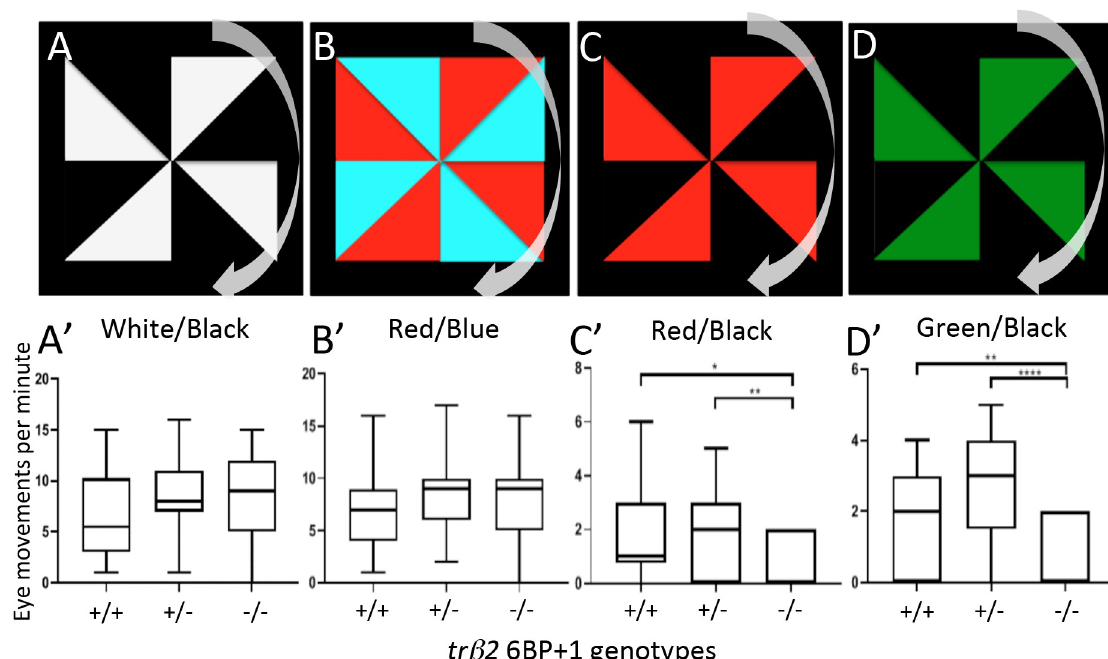
Fig 13. Optokinetic response tests. (A, B, C, D) Each larva at 9 dpf was exposed to these four stimuli in left to right order. The pinwheel patterns moved clockwise. (A’, B’) The wild type, 6BP+1 heterozygote, and 6BP+1 mutant responded similarly to the white/black and red/ blue stimuli. (C’, D’) The mutant had significantly less eye movements in response to the red/black and green/black stimuli. There was one repetition for each wild type (N = 30), heterozygote (N = 37), and mutant (N = 19) larvae. Monitor peak wavelengths are red (~610 nm), green (~550 nm), and blue (~450 nm). Significance is calculated with Mann-Whitney U test. red/black, and green/black pinwheels (Fig 13A, 13A’, 13B, 13B’, 13C, 13C’, 13D and 13D’). The 6BP+1 homozygous mutant fish (-/-) show OKR responses for white/black and red/blue pinwheels, but not red/black (~610 nm) or green/black (~550 nm) pinwheels. The mutant red/ black OKR responses (Mdn = 0.0) were significantly lower than WT (Mdn = 1.0) ( Mann Whit- ney , U = 188, P < 0.05) and the heterozygous mutant (Mdn = 2.0) ( Mann Whitney , U = 197, P < 0.01, Fig 13C’). There was a significant decrease in the number of green/black OKRs between the homozygous mutant fish (Mdn = 0.0) and WT (Mdn = 2.0) ( Mann Whitney , U = 168, P < 0.01) or heterozygous mutant (Mdn = 3.0) ( Mann Whitney , U = 118, P < 0.0001. Fig 13D’). In respect to OKR behavior, the 6BP+1 tr β 2 mutant fish do not respond to the mon- itor colors red (~610 nm) or green (~550 nm). Both colors selectively stimulate zebrafish red cones. This suggests the 6BP+1 mutants, lacking red cones, can use shorter-wavelength cones for OKR given the positive responses to the red/blue pinwheel stimulus. The blue stimulus (~450 nm peak) significantly overlaps with the 460 nm peaking larval green cones. Loss of red response in 6BP+1 mutant adult zebrafish As in 6BP+1 homozygous mutant larvae, adult 6BP+1 mutant fish are unresponsive to long wavelength stimuli. In a cone-PIII dataset from an adult 6BP+1 mutant fish (Fig 14A), no cone PIII responses are evoked by 650 nm stimuli of any brightness, whereas WT and heterozygous mutants respond well at multiple brightness’s (Fig 14B and 14C). For the 6BP+1 mutant only the brightest of 570 nm stimuli produces a response, while the WT and 6BP+1 heterozygous adults respond vigorously to multiple stimulus irradiances. For wavelengths eliciting responses, there is little change in response kinetics between the three adult genotypes.